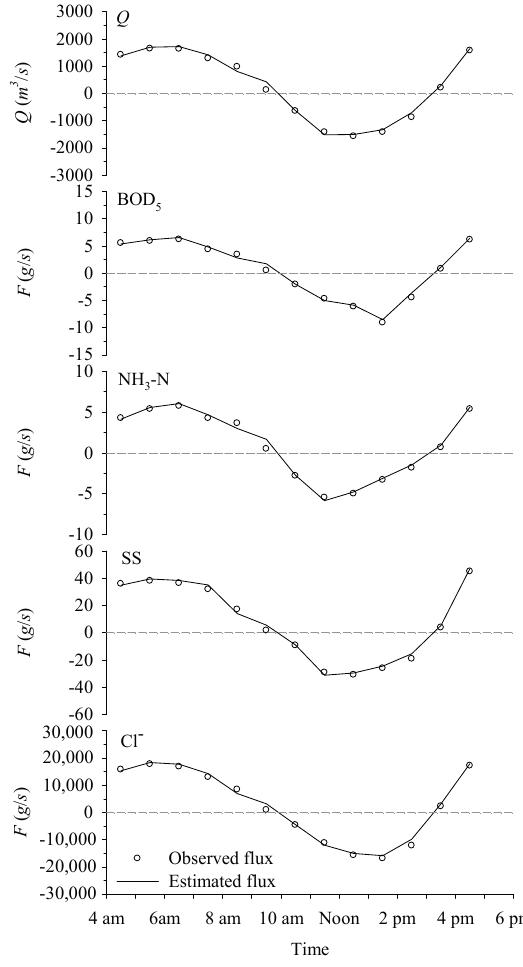
Figure 7. Comparison of measured and estimated flux curves during flood, slack and ebb tides. Field observations conducted in the Danshui River Estuary at the Guando Bridge on 4 May